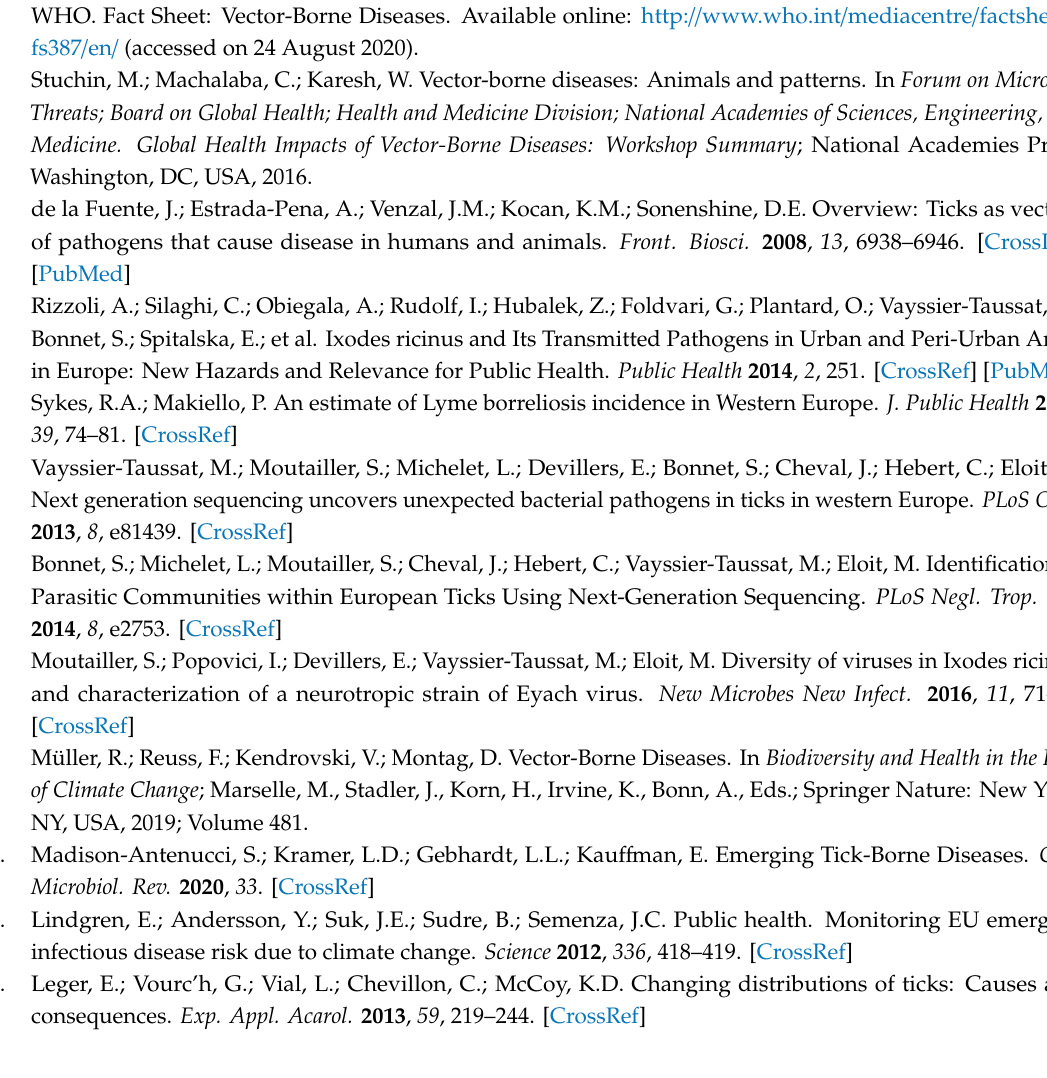
Figure S1: Correlation between antibody titers against recombinant IrSPI and IrLip1 in vaccinated sheep, and e ff ect on tick